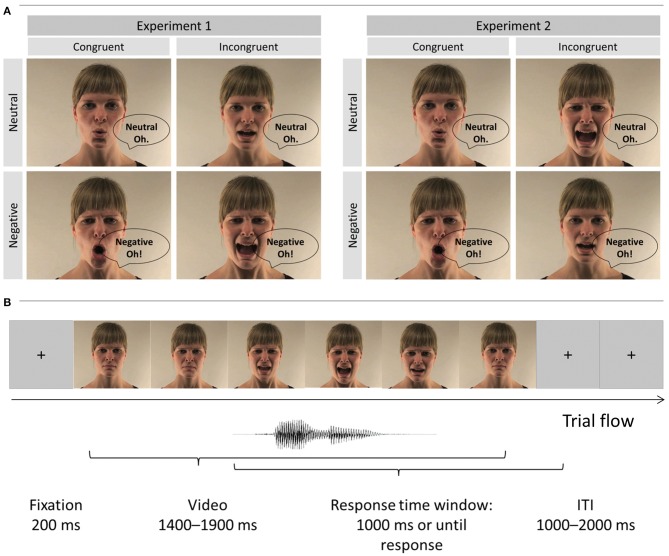
(A) Multimodal video stimuli of Experiments 1 and 2: Example of the female actor (publication of these images was approved by the actor) vocalized the interjections “A” and “O” in either a negative or neutral tone of voice. Incongruence was created by a mismatch of the vocalizations and the video components in Experiment 1 and mismatches in emotion of audio and video components in Experiment 2. (B) Example of a trial sequence. The trial started with a 200 ms fixation point that was followed by a video clip played in full length. The length of videos was varied (see Tables 3, 4 for details). The response time window was activated with the voice onset and lasted until response or a maximum of 1,000 ms. We also introduced a random inter-trial interval between 1,000 and 2,000 ms. Please note that speech bubbles “neutral” and “negative” refer to the [audio] target dimension (not visual dimension).